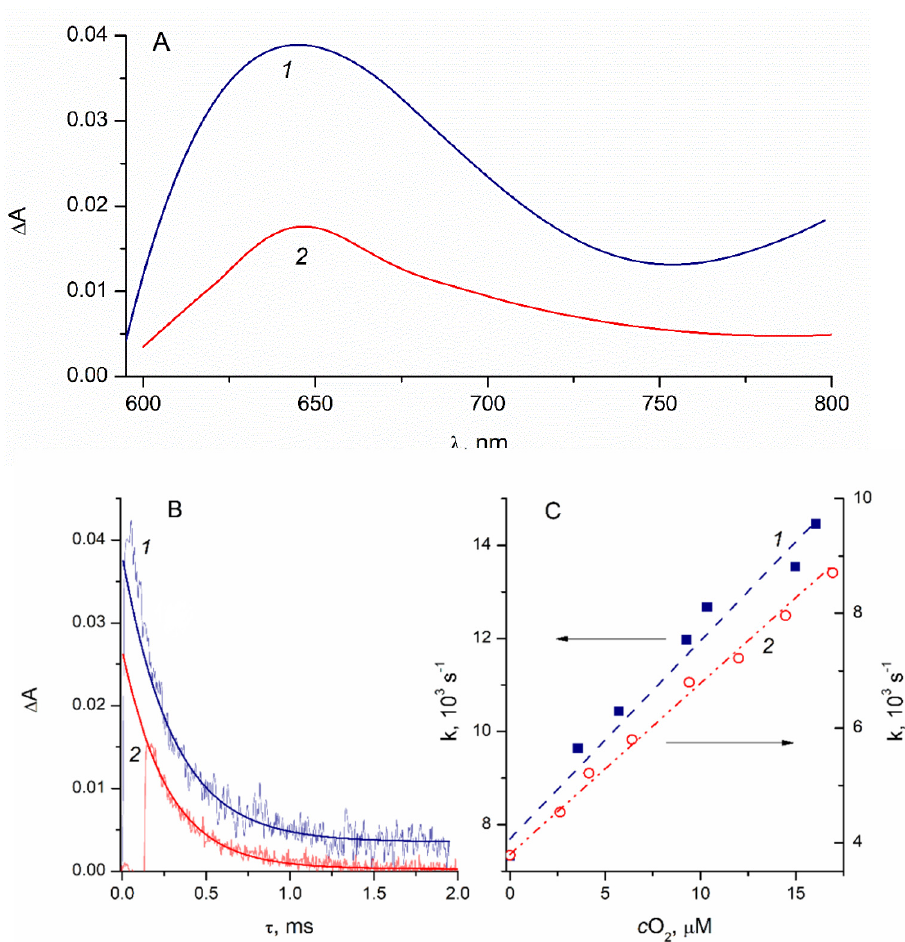
Figure 23. ( a ) Difference T–T absorption spectra of dye 20 in phosphate buffer in the presence of dsDNA ( 1a ; c dye = 1.4 × 10 –6 mol L − 1 ; c dsDNA = 2.28 × 10 –4 mol L − 1 ) and in the presence of ssDNA ( 2a ; c dye = 2.4 × 10 –6 mol L − 1 ; c ssDNA = 2 × 10 –4 mol L − 1 ; ( b ) decay kinetics of the T state of the dye with dsDNA ( 1b , λ reg = 640 nm) and ssDNA ( 2b λ reg = 650 nm) with monoexponential fittings; ( c ) dependences of the T state decay rate constant ( k , 10 3 s − 1 ) obtained in the presence of dsDNA ( 1c ) and ssDNA ( 2c ) on the oxygen concentration.